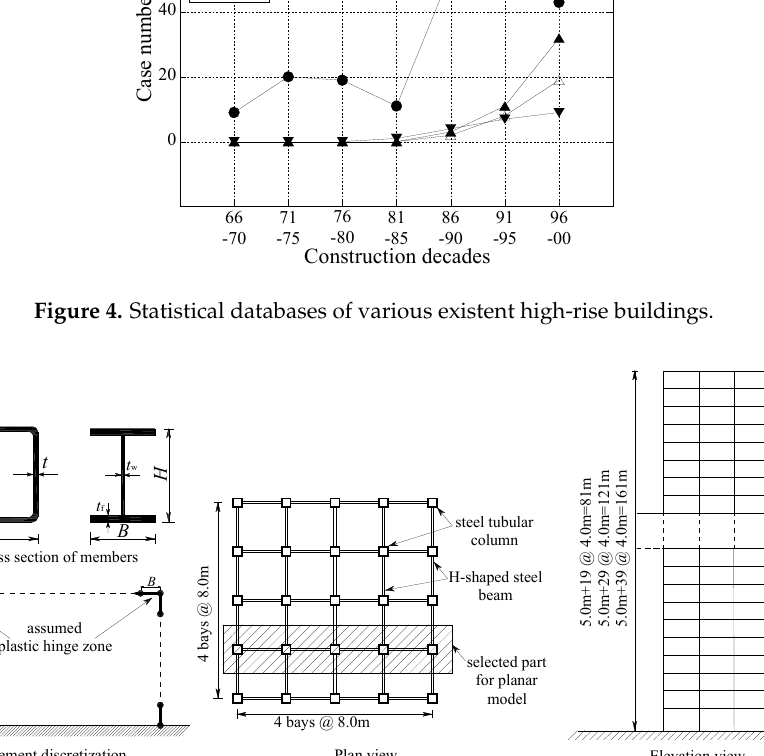
Figure 5. Members, element discretization, plan and elevation view of high ‐ rise SMRF (steel moment ‐ resisting frame) models.